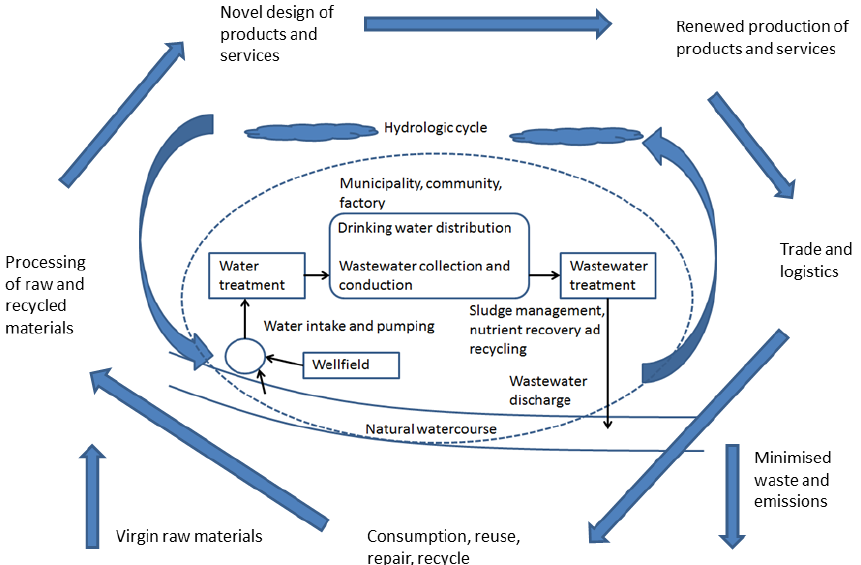
Figure 1. Relationships between hydrologic cycle, urban water cycle and principles of circular economy, presented in [26].